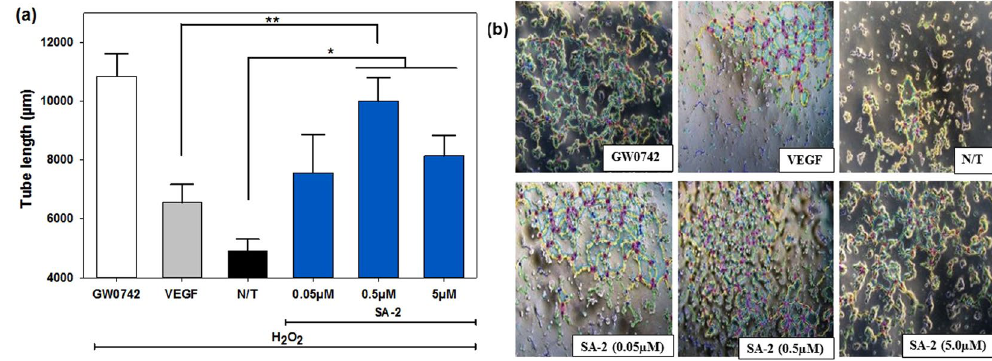
Figure 4. SA-2 promoted angiogenesis in ECs under an oxidative stress condition: ( a ) tube length and ( b ) representing images for angiogenesis analysis. Cells were seeded on Cultrex gel on tissue culture plates and stressed with H 2 O 2 . SA-2 at different concentrations, G0742 (1 µ M), or VEGF (25 ng/mL) was added to each well. N/T samples were cells exposed to H 2 O 2 only. After 8 hours, at least 10 images were randomly captured on a phase contrast microscope for each well (n = 4 wells/sample). Images were analyzed and quantified for length of microtubes formed using ImageJ with Angiogenesis Analyzer tools. Results were then processed on SigmaPlot for statistical analysis using ANOVA followed by post hoc comparisons. Data are shown as mean values ± SEM. Stars indicate significant differences (p < 0.05) with respect to N/T ( * ) and VEGF ( ** ).